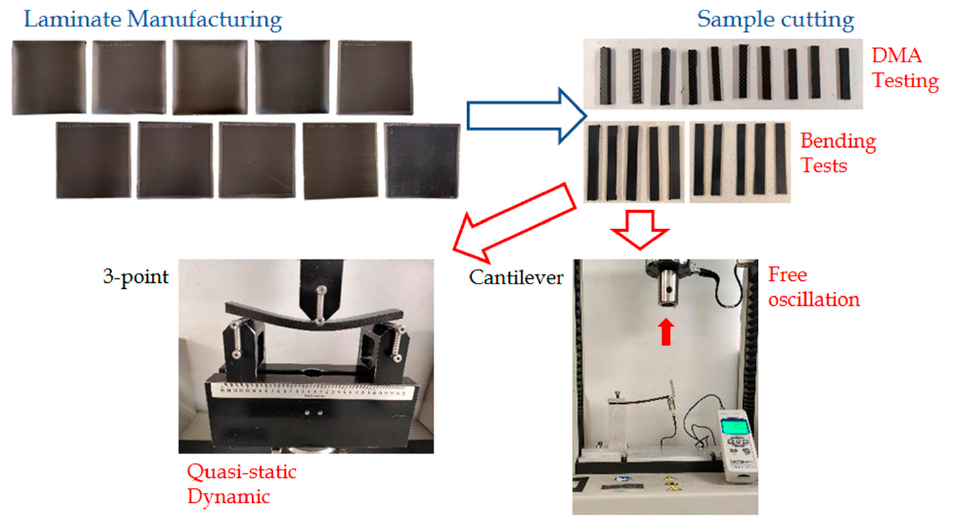
Figure 1. Experimental